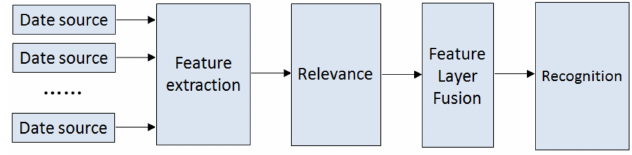
Figure 1. Feature layer information fusion.